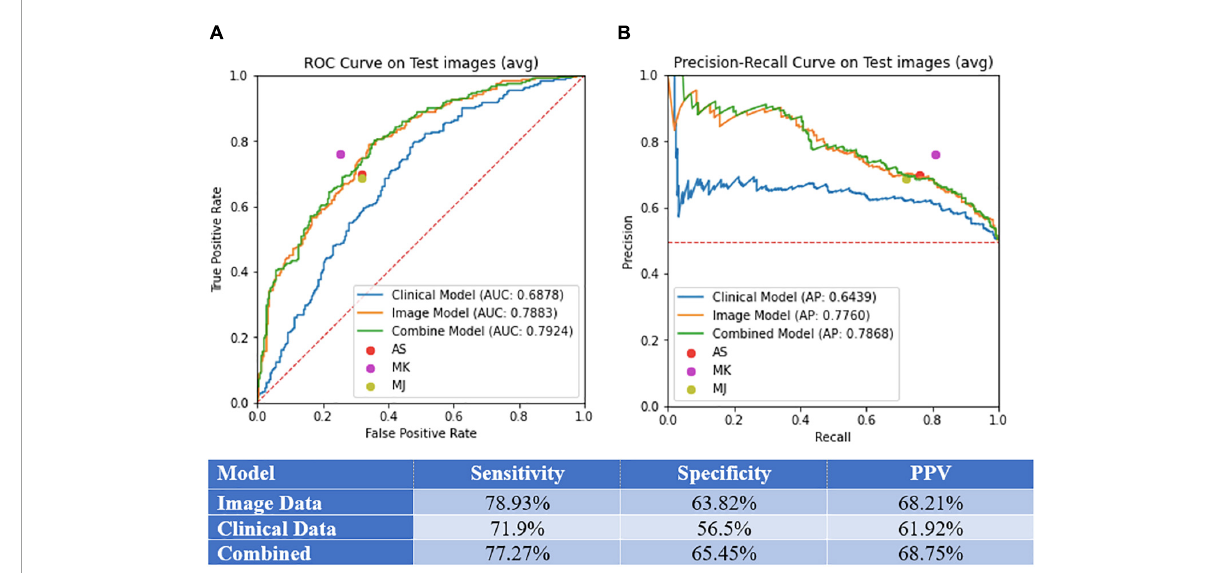
FIGURE3 Model performance. (A) Area under the curve (AUC) of receiver operating curve (ROC) and precision-recall curves on test images. (B) Sensitivity, specificity, and PPV for the image-alone, clinical data-alone, and combined